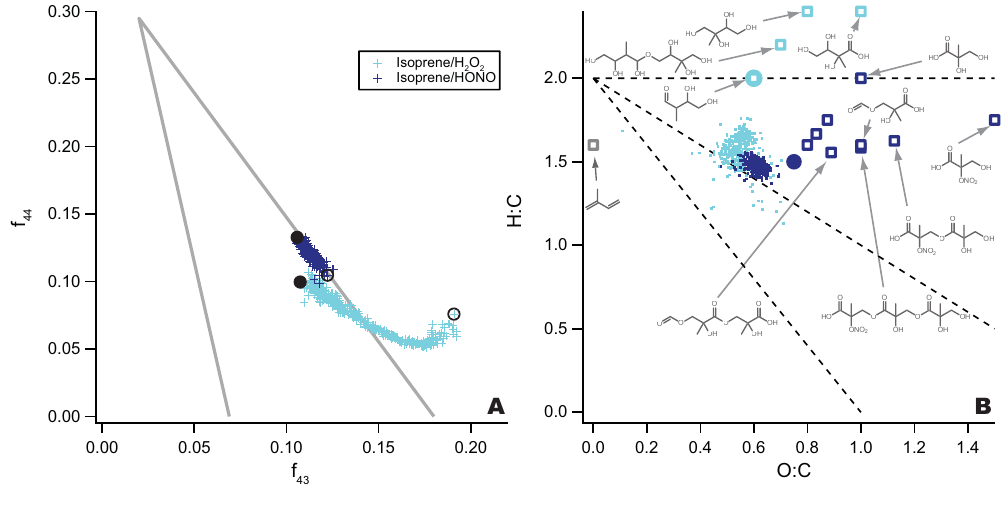
Fig. 3. (A) “Triangle plot” for SOA formed from photooxidation of isoprene under low- and high-NO x conditions. Open and closed black circles represent the beginning and end of the experiments, respectively. (B) Van Krevelen diagram for SOA formed from photooxidation of isoprene under low- and high-NO x conditions Identified SOA products of each NO x condition are presented in blue boxes of the corre- sponding color (Surratt et al., 2006; Claeys et al., 2004; Wang et al., 2005; Surratt et al., 2007; Gomez-Gonzalez et al., 2008). Surratt et al. (2006) found that under low-NO x conditions, ∼ 25–30% of the SOA mass in seeded experiments is organic peroxides, and under high-NO x conditions, oligomers comprise ∼ 22–34% of the SOA mass. Oligomeric limits for each NO x condition are represented by circles.